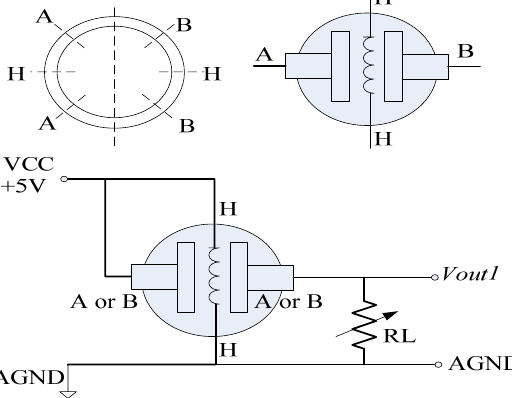
Figure 8. Structure and measuring circuit of semiconductor gas sensitive units.